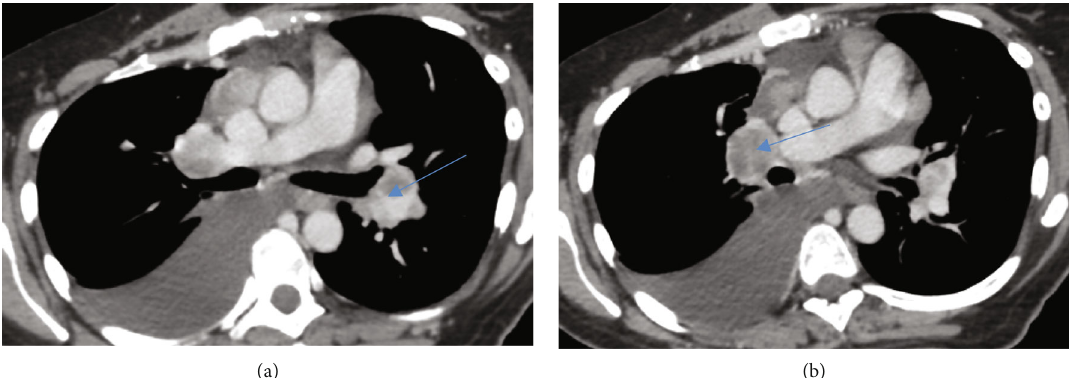
Figure 2: CT chest. (a) Con fl uent prevascular nodal mass measuring 4 : 1 × 2 : 4 cm. (b) Right hilar lymph node measuring 2 : 5 × 3 : 1 cm.